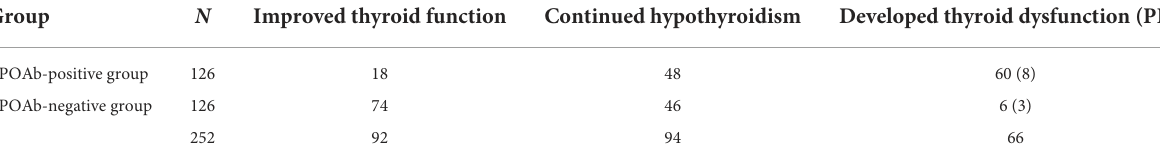
TABLE 1 Thyroid function of the 12th month postpartum in TPOAb-positive and -negative groups. Group N Improved thyroid function Continued hypothyroidism Developed thyroid dysfunction (PPT)